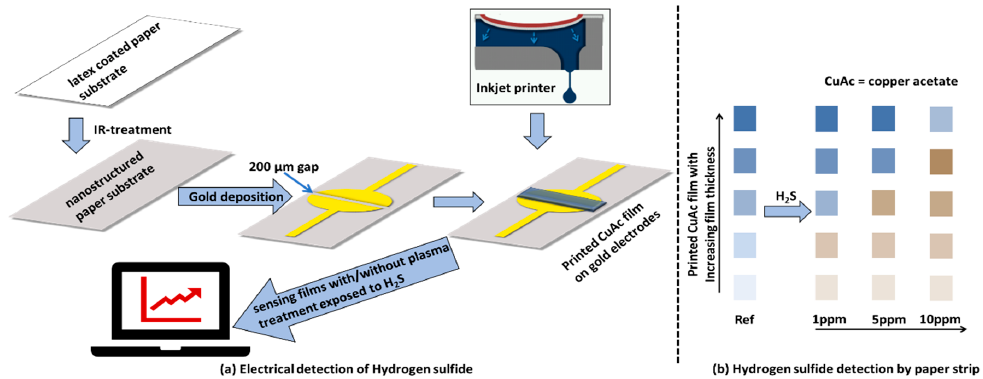
Figure 1. Schematic illustration of the development of gas sensing film on nano-structured paper substrate for electrical detection ( a ) and on specialty-paper substrate for colorimetric detection ( b